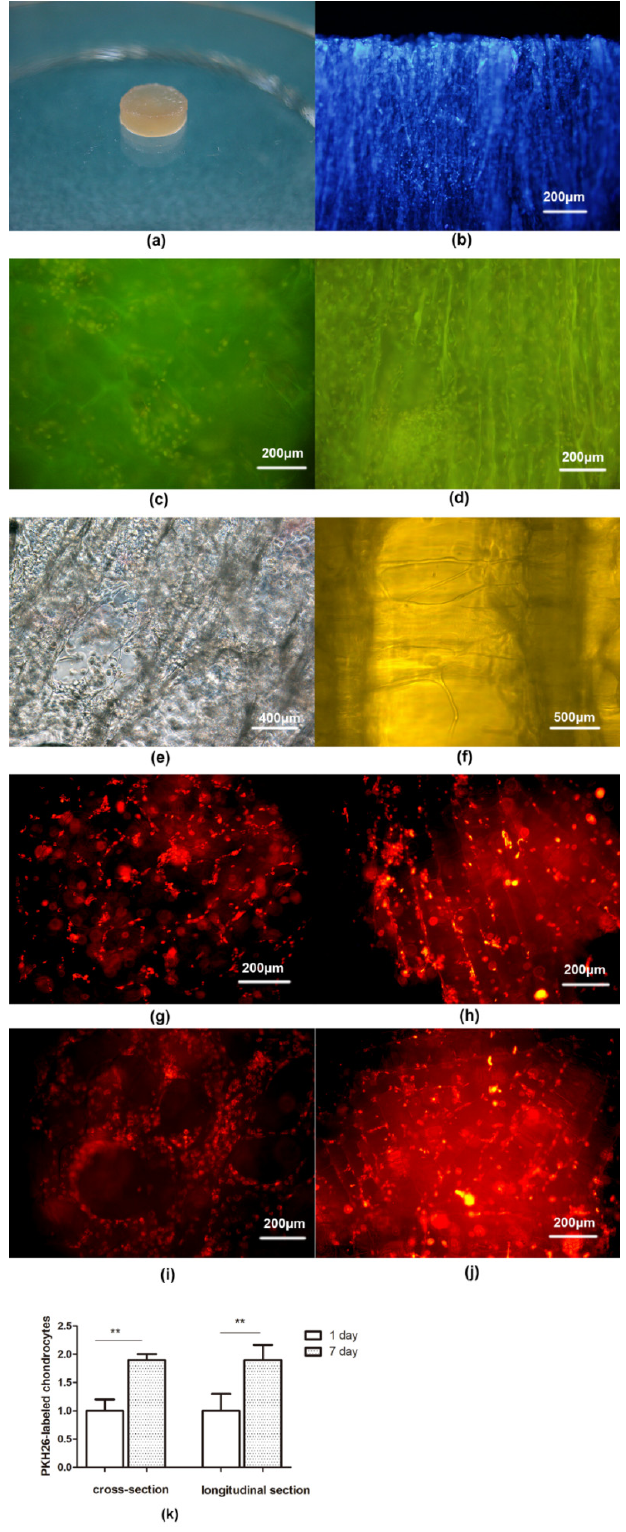
Figure 4. ( a ) After 1 week (7 d) of in vitro culture, the cells were combined into the scaffold. ( b ) Distribution of pig chondrocytes (Hoechst 33258 labeled nuclei) on the scaffolds (inverted fluores- cence microscopy, ×100 magnification). ( c ) Fluorescence microscopy of acridine orange-propidium io- dide (AO-PI)-stained sample after 24 h inoculation (cross-section, × 100 magnification). ( d )